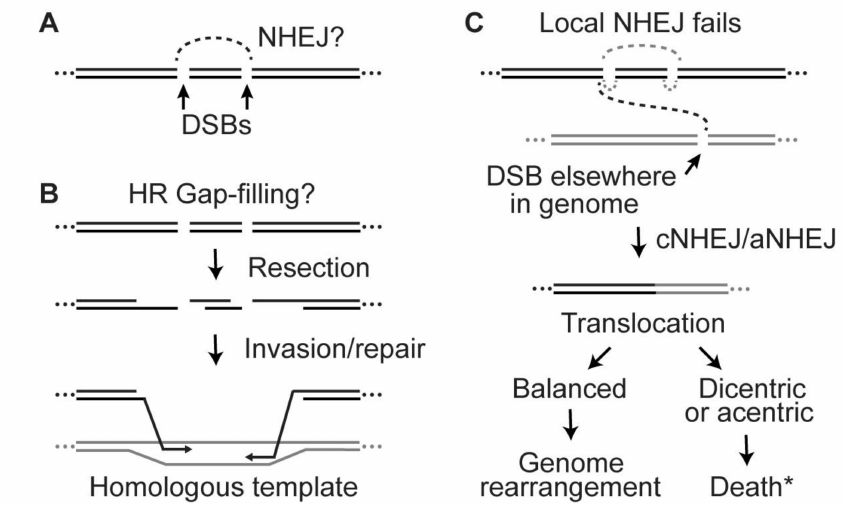
Figure 4. Key questions about clustered DSB repair, illustrated with 2-DSB clusters. ( A ) Short DNA fragments inhibit cNHEJ but it is unclear why distal broken ends, which are termini of long DNA fragments, are not e ffi ciently rejoined (dashed line) by NHEJ. ( B ) Why do the distal ends of a DSB cluster not invade homologous sequences and repair the gap via HR? ( C ) If local NHEJ is delayed or fails at clustered DSBs (grey dashed lines), this may provide time for broken ends to migrate and rejoin with a broken end elsewhere in the genome by cNHEJ or aNHEJ, producing translocations. Balanced translocations are probably survivable events despite the large-scale genome rearrangement. However, unbalanced translocations create dicentric and / or acentric chromosomes that are frequently lethal. “Death*” indicates death plus other possible outcomes, such as stimulation of bridge-breakage-fusion cycles and persistent genome instability